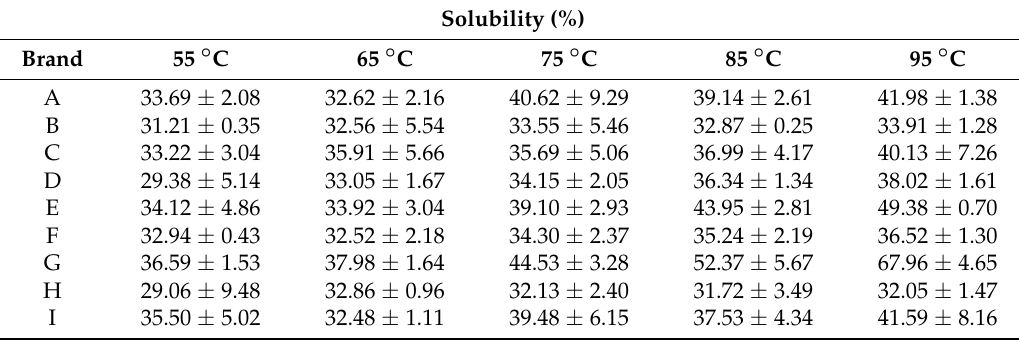
Table 6. Solubility analysis of herbal pharmaceutical products at different temperatures.